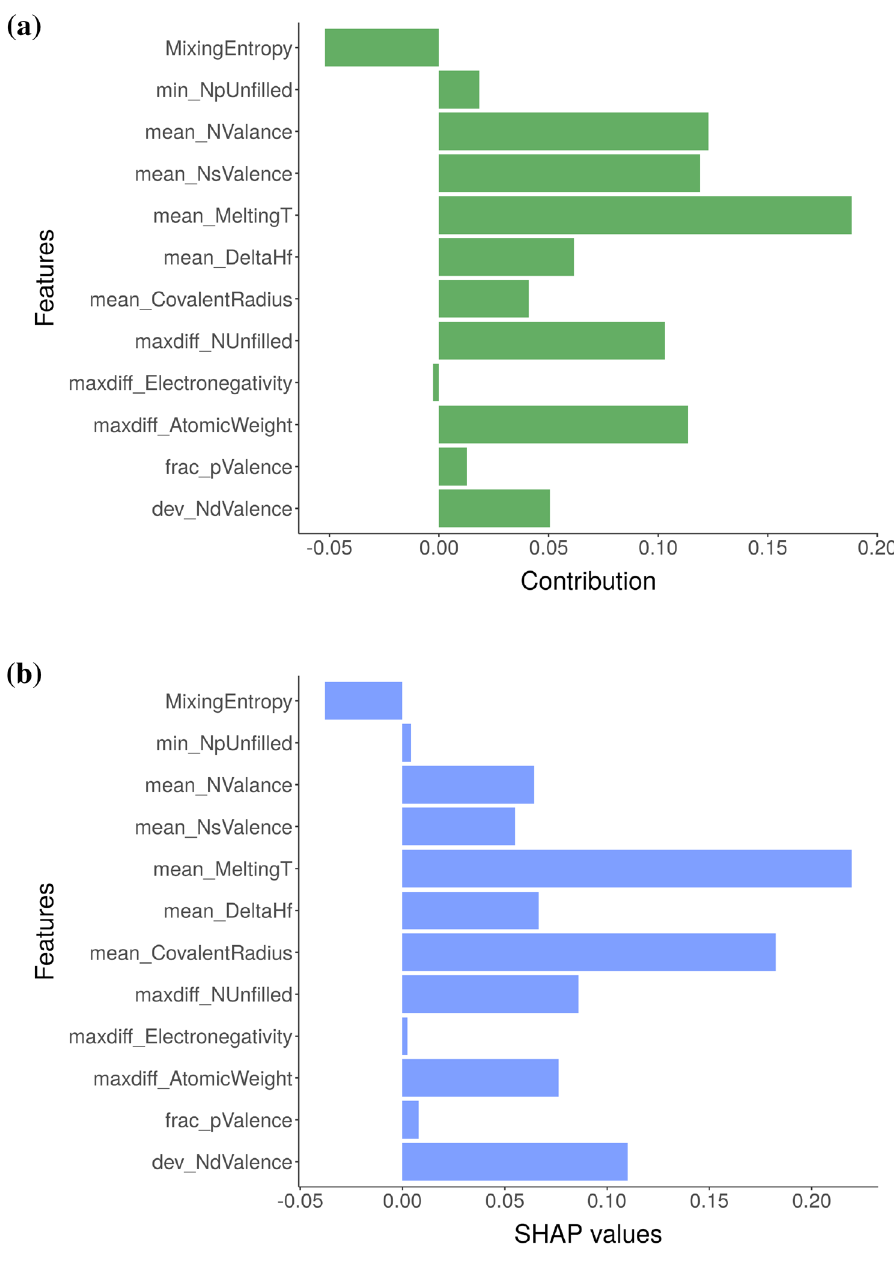
Figure 1. The ( a ) BD and ( b ) SHAP decomposition are plotted for the NbTaTiV composition, which is predicted to form in the BCC phase by the eSVM model. The y-axis of SHAP plot is sorted in the same way as that of the BD plot to facilitate the comparison of two